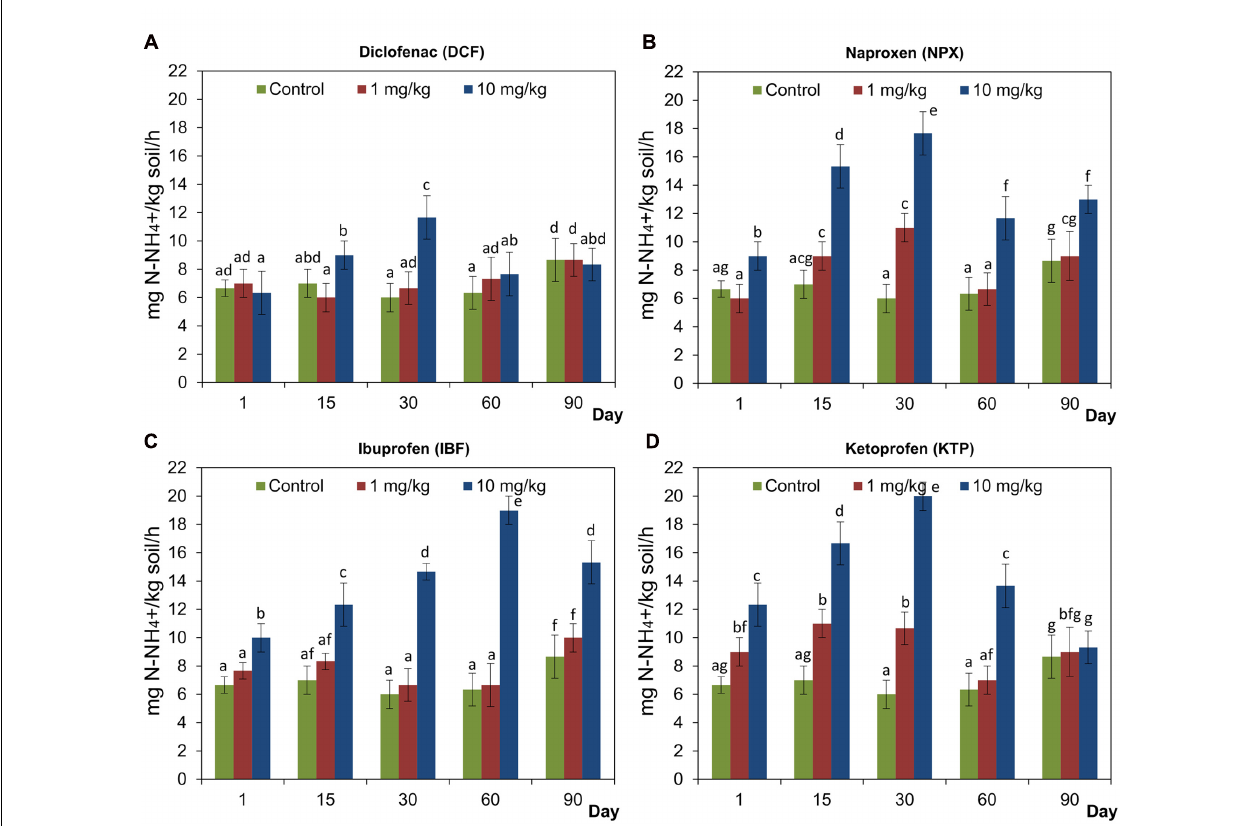
FIGURE 8 | Concentration of N-NH 4 + in control soil and soil treated with diclofenac (A) , naproxen (B) , ibuprofen (C) , and ketoprofen (D) at concentrations of 1 and 10 mg/kg soil during the 90-day experiment. The data presented are the means and standard deviations of three replicates and are expressed as mg N-NH 4 + /kg soil. Different letters (within each drug) indicate significant differences ( P < 0.005, LSD test) related to the effects of concentration and